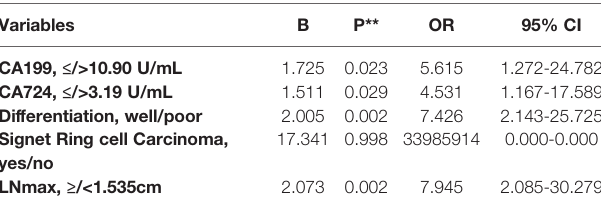
TABLE 3 | Multivariate analysis: variables correlated with TRG in the training set.